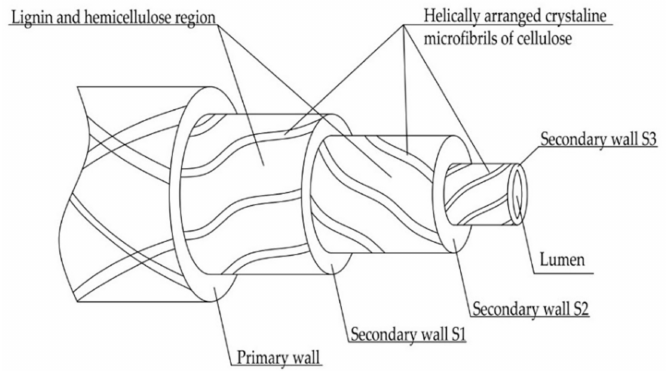
Figure 2. Schematic of coconut